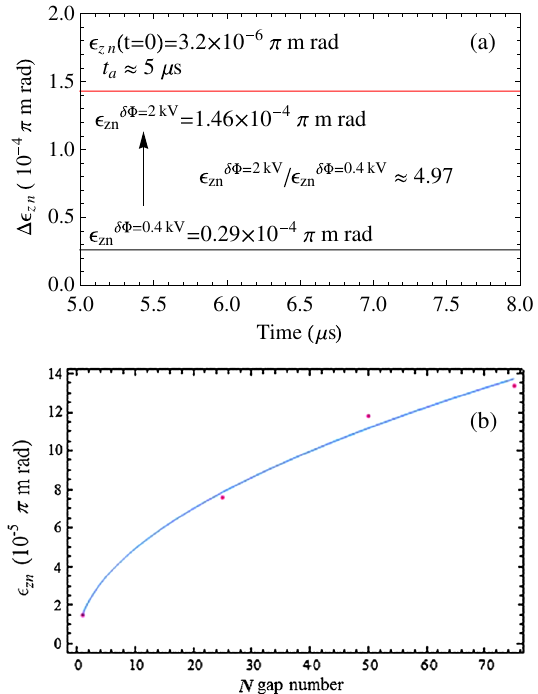
ð t Þ plot: the red curve represents the gap with FIG. 4. (a) (cid:1) (cid:1) zn (cid:5) (cid:2) ¼ 2 kV and the black curve represents the gap with (cid:5) (cid:2) ¼ ð t Þ plot for Rb beams accelerated by a different 0 : 4 kV . (b) (cid:1) zn number of time-varying voltage fluctuation gaps, shown by the red dots. The blue curve is the best-fit curve for these four data